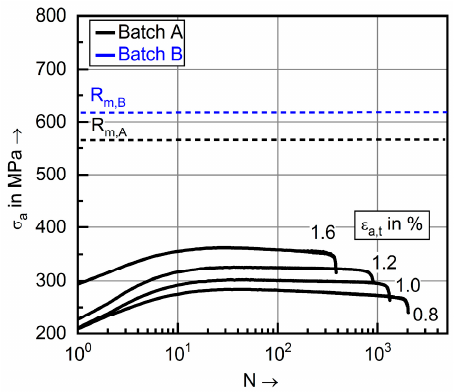
Figure 7. Development of stress amplitude σ a versus load cycles N during total-strain controlled LCF test at T = 300 °C of batch A.